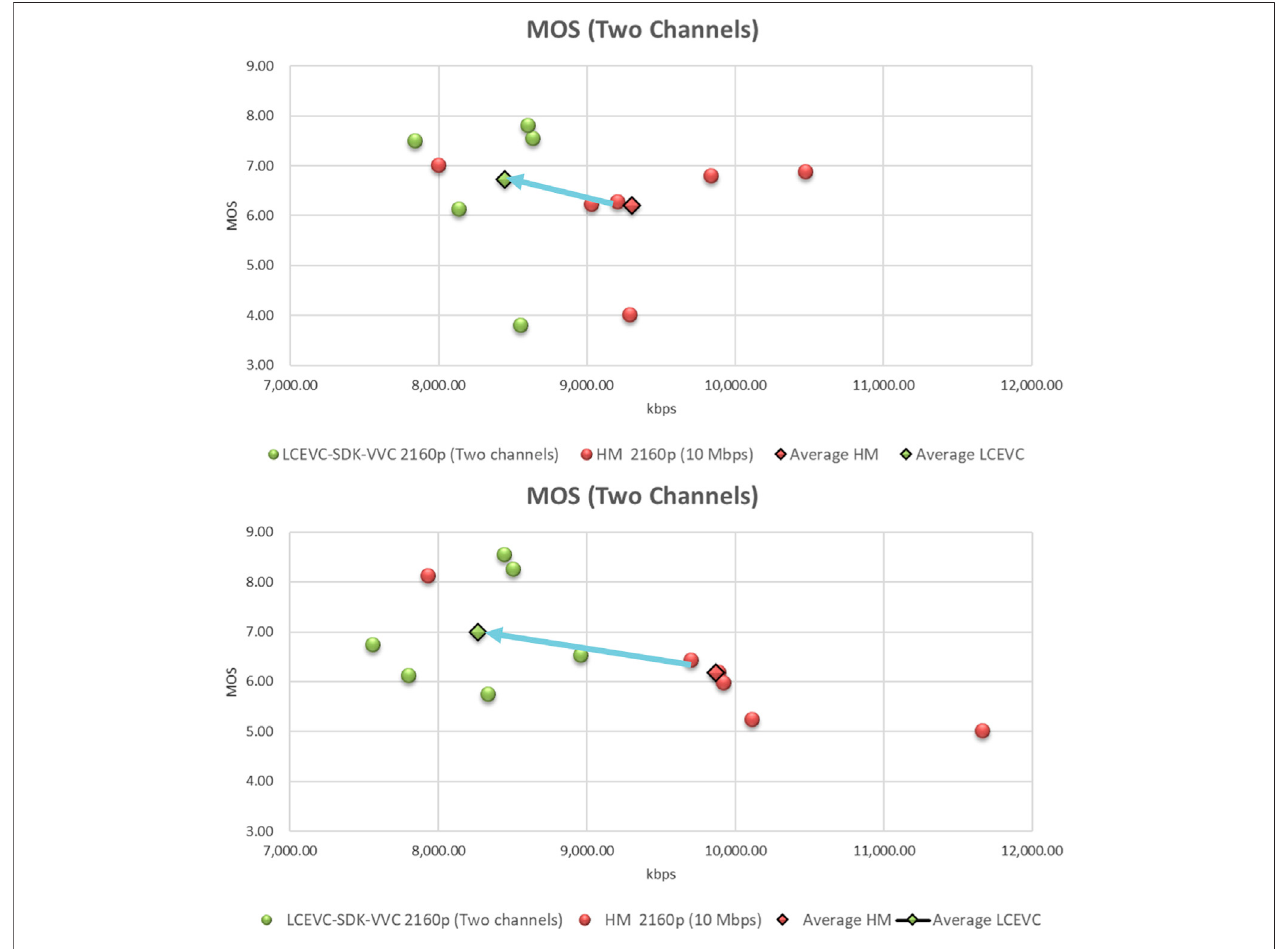
FIGURE 12 | Chart showing MOS scores for PQ ( Table 9 ) and HLG ( Table 10 )